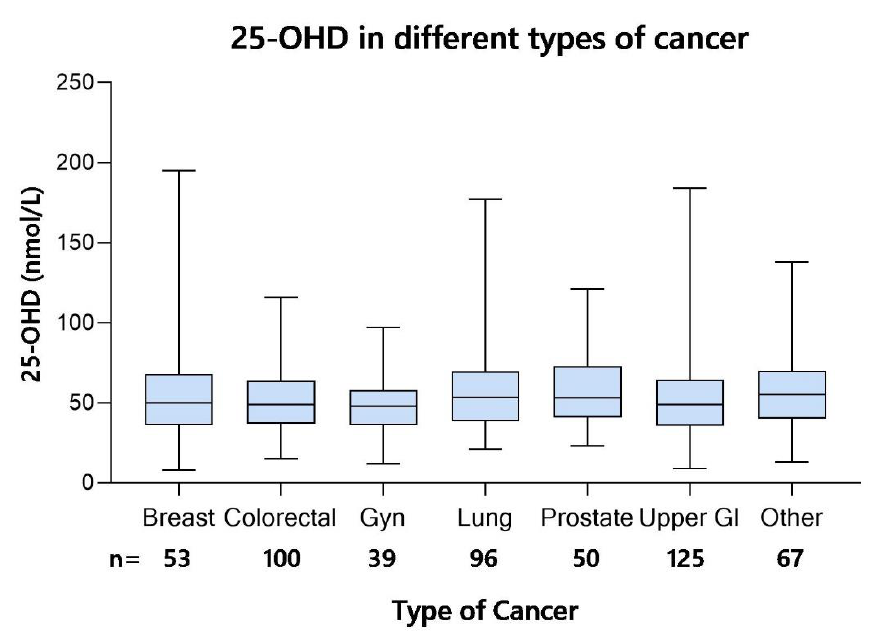
Figure 3. Cross-sectional 25-OHD in relation to tumor type ( n = 530). Median 25-hydroxyvitamin D (25-OHD) values in nmol/L in patients with different types of cancer from the screening cohort of the ‘Palliative-D’-study. Boxes show interquartile range and whiskers min-max values. There were no statistically significant differences between groups (Kruskal Wallis).